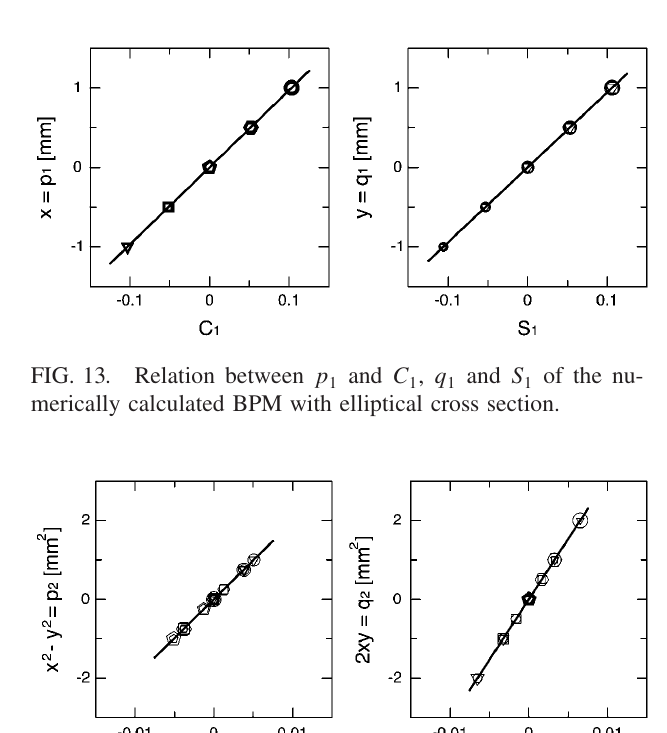
and C 0 , q and S of the nu- 2 2 2 2